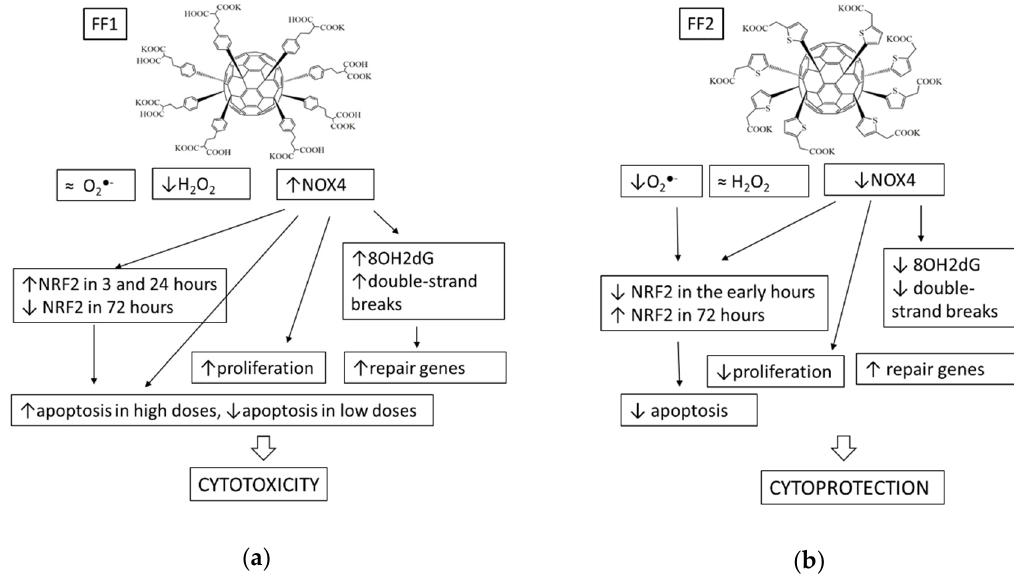
Figure 16. Schematic representation of mechanisms of cytotoxic or cytoprotective effects of ( a ) FF1 and ( b ) FF2.